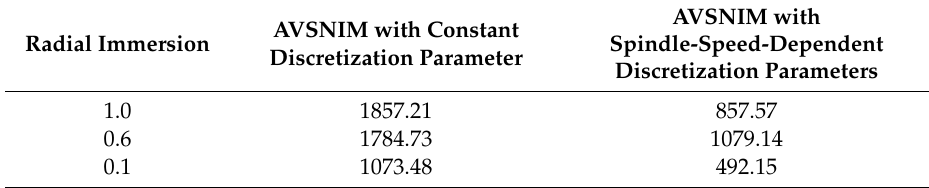
Figure 8. Numerical simulation of time step and discretization parameters, ( a ) time step of equal-step method; ( b ) time step of variable-step method; ( c ) discretization parameters obtained by the spindle-speed-dependent discretization algorithm. Table 2. Calculation time required for the AVSNIM with constant discretization parameter and spindle-speed-dependent discretization parameters (unit: